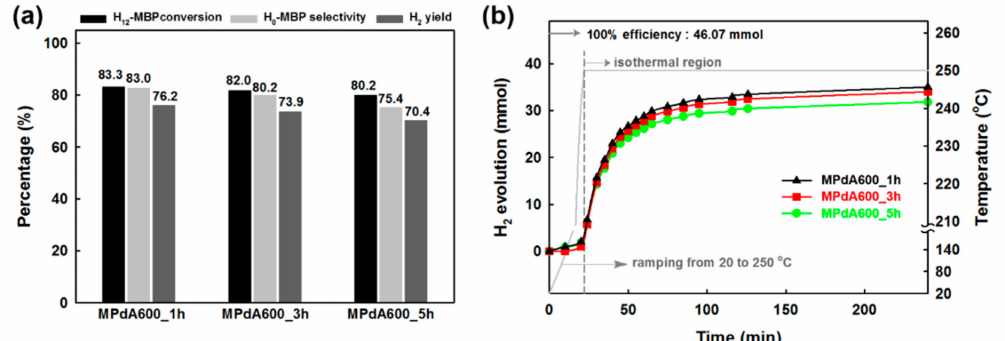
Figure 6. ( a ) Activity results obtained through the GC; ( b ) time-dependent H 2 release curves of the MPdA catalysts calcined at 600 ◦ C for di ff erent calcination durations in the dehydrogenation of H 12 -MBP at M / R ratio of 0.1 mol% and 250 ◦ C for 4